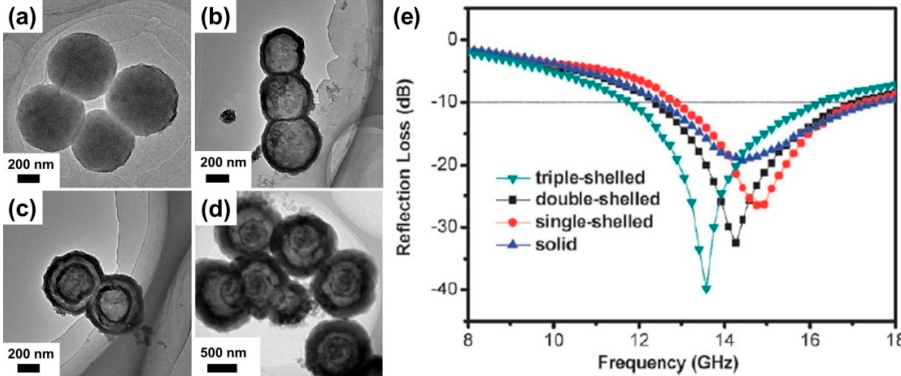
Figure 4. ( a ) TEM images of poly(3,4-ethylenedioxythioxythiophene (PEDOT) solid spheres, ( b ) single-shelled PEDOT hollow spheres, ( c ) double-shelled PEDOT microspheres, and ( d ) triple-shelled PEDOT microspheres; ( e ) Reflection loss for different morphologies of PEDOT microspheres in the frequency range of 8.0–18.0 GHz with a thickness of 2 mm. Reprinted with permission from Reference [34].